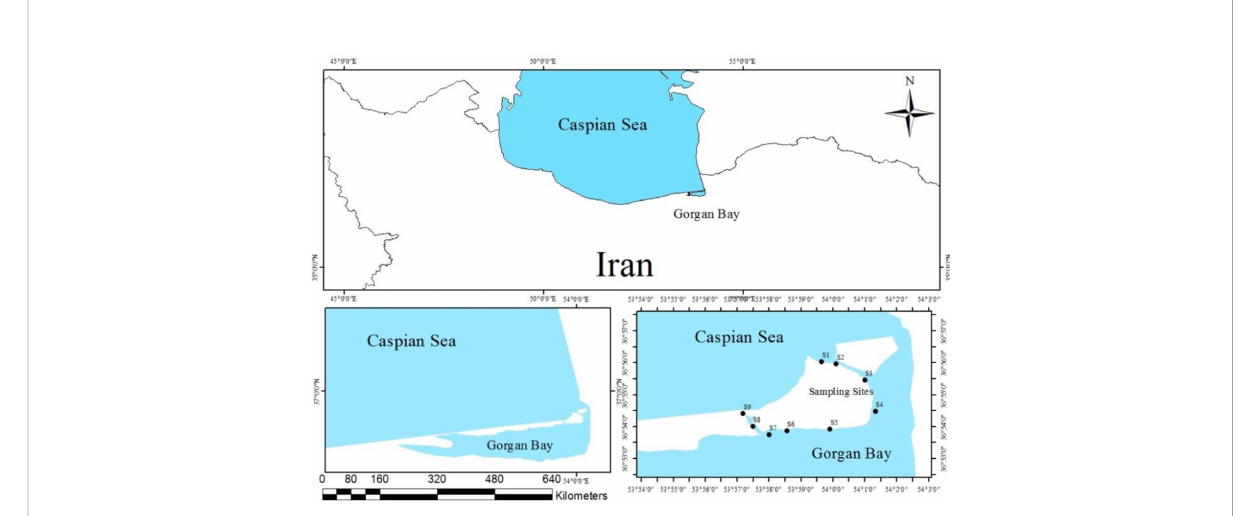
FIGURE 1 Sampling localities of P. elegans and P. adspersus in the southeast Caspian Sea – Iran (2019 –